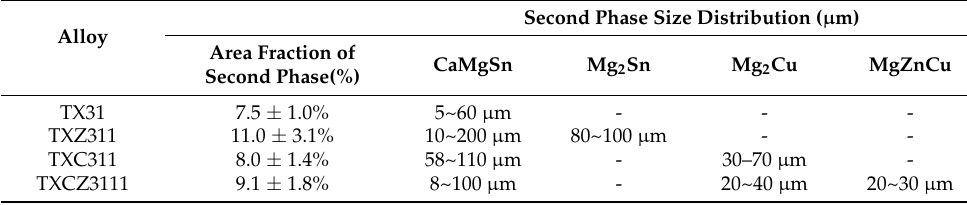
Table 2. The area fraction and size distribution of the second phase.